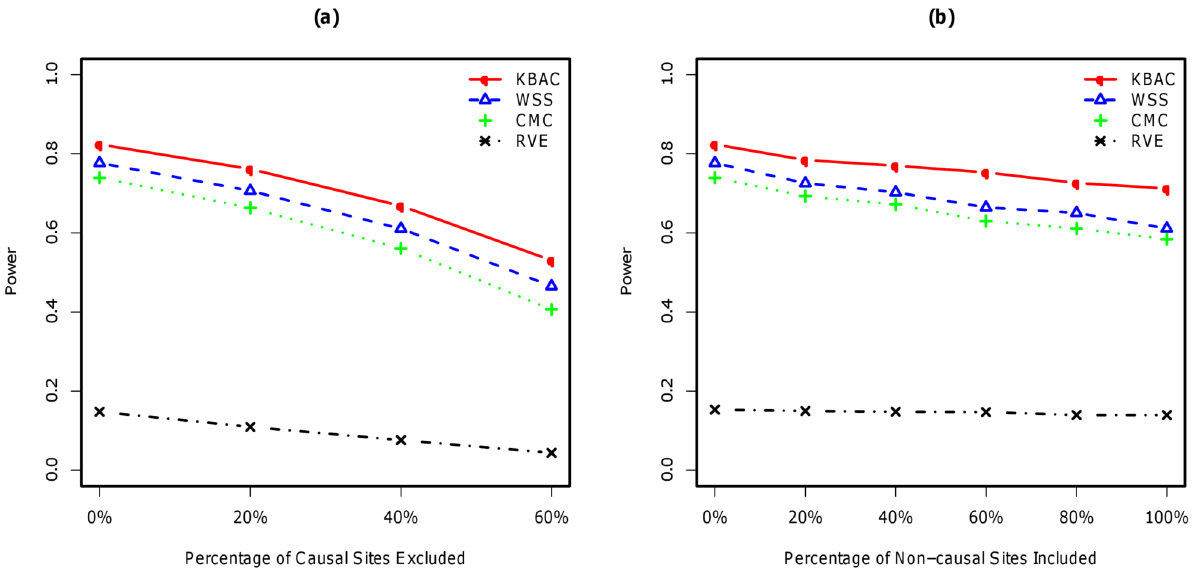
Figure 2. Impact of misclassifications under main effects model with fixed genetic effects using simulated SFS for AA. Each causal rare variant has an OR=3.0. Power comparisons were made for the KBAC, WSS, CMC, and RVE when 0% , 60% of causal rare variants are excluded from the analysis (left panel) and when 0% , 100% of non-causal rare variants are included (right panel). A sample size of 1000 cases and 1000 controls was used for each scenario. P-values were empirically estimated using 5,000 permutations and power was evaluated for a significance level of a ~ 0 : 05 using 2,000 replicates for each scenario.